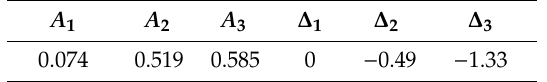
Table 2. Oscillation amplitudes and phase shifts of the harmonics functions